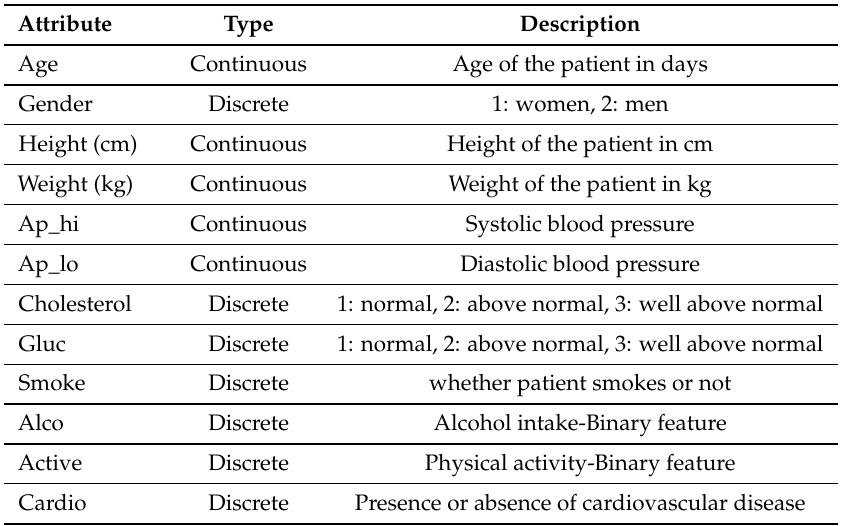
Table 2. Twelve attributes of Cardiovascular Diseases